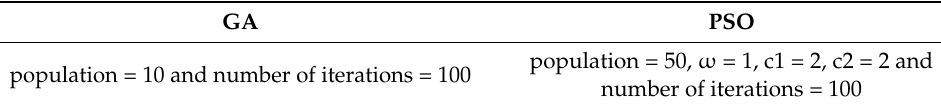
Table A1. Parameters of GA and